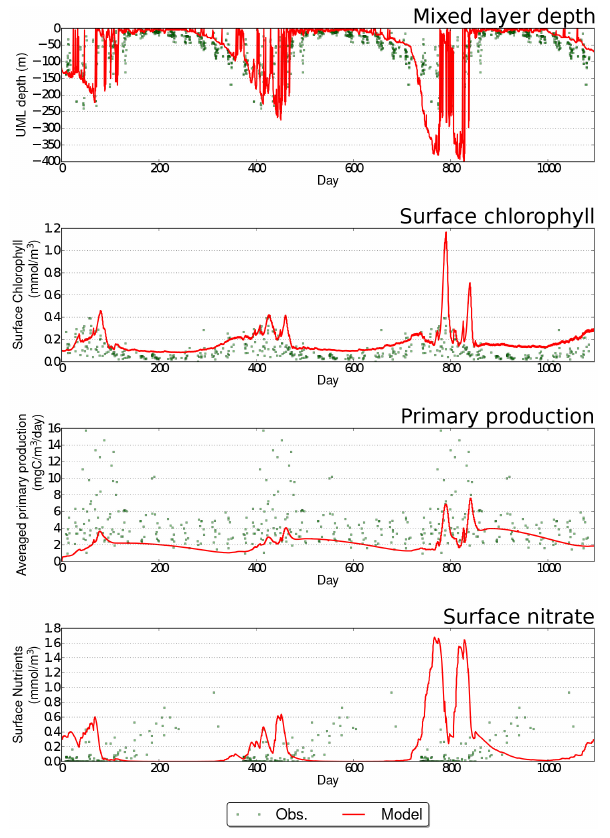
Fig. 3. Summary of simulated physical and biological behaviour at Bermuda for a uniform (2.5m), non-adaptive simulation. From top to bottom, panels show MLD, surface chlorophyll, averaged pri- mary productivity and surface nutrients. Where available, measured data are shown as green squares. Measured data are plotted against day of year due to lack of data for some quantities.